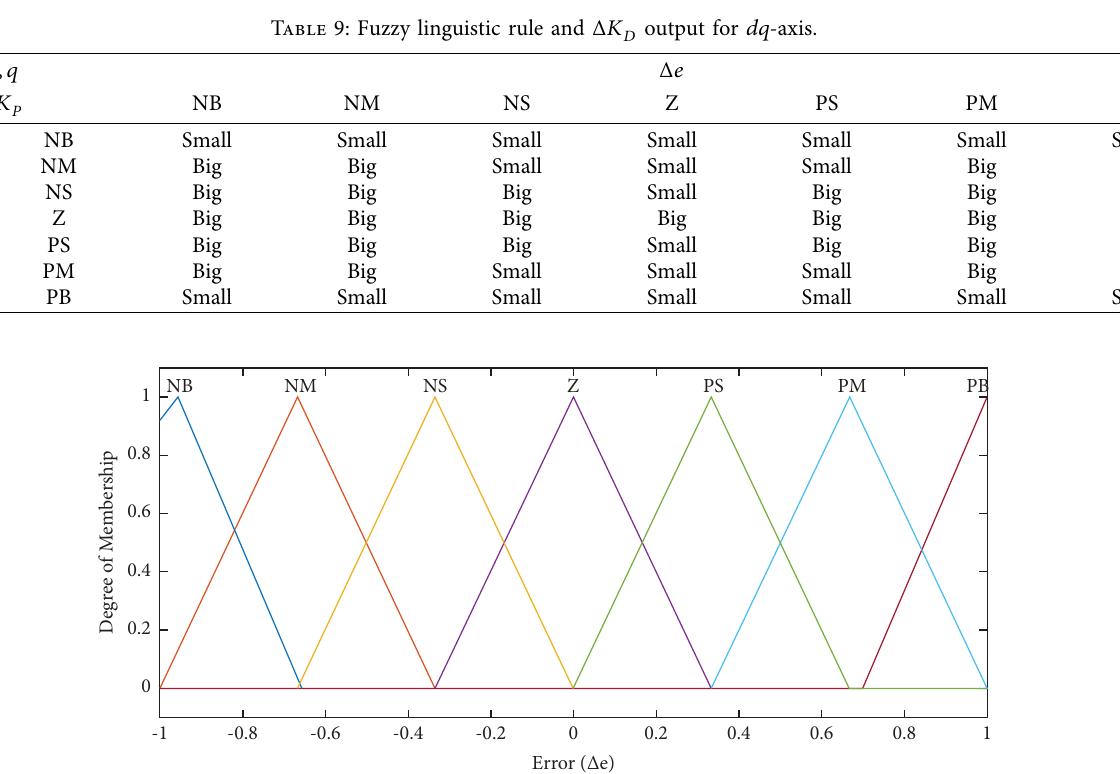
Figure 10: Input (error) for dq